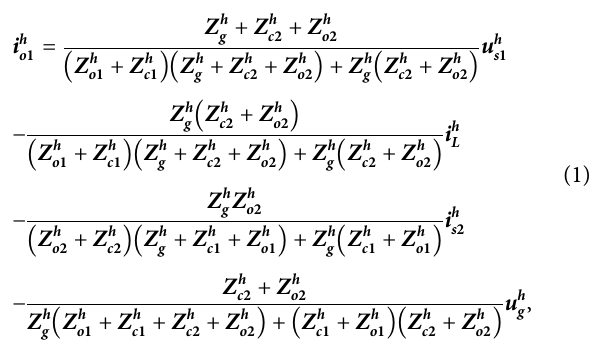
Frontiers in Energy Research |